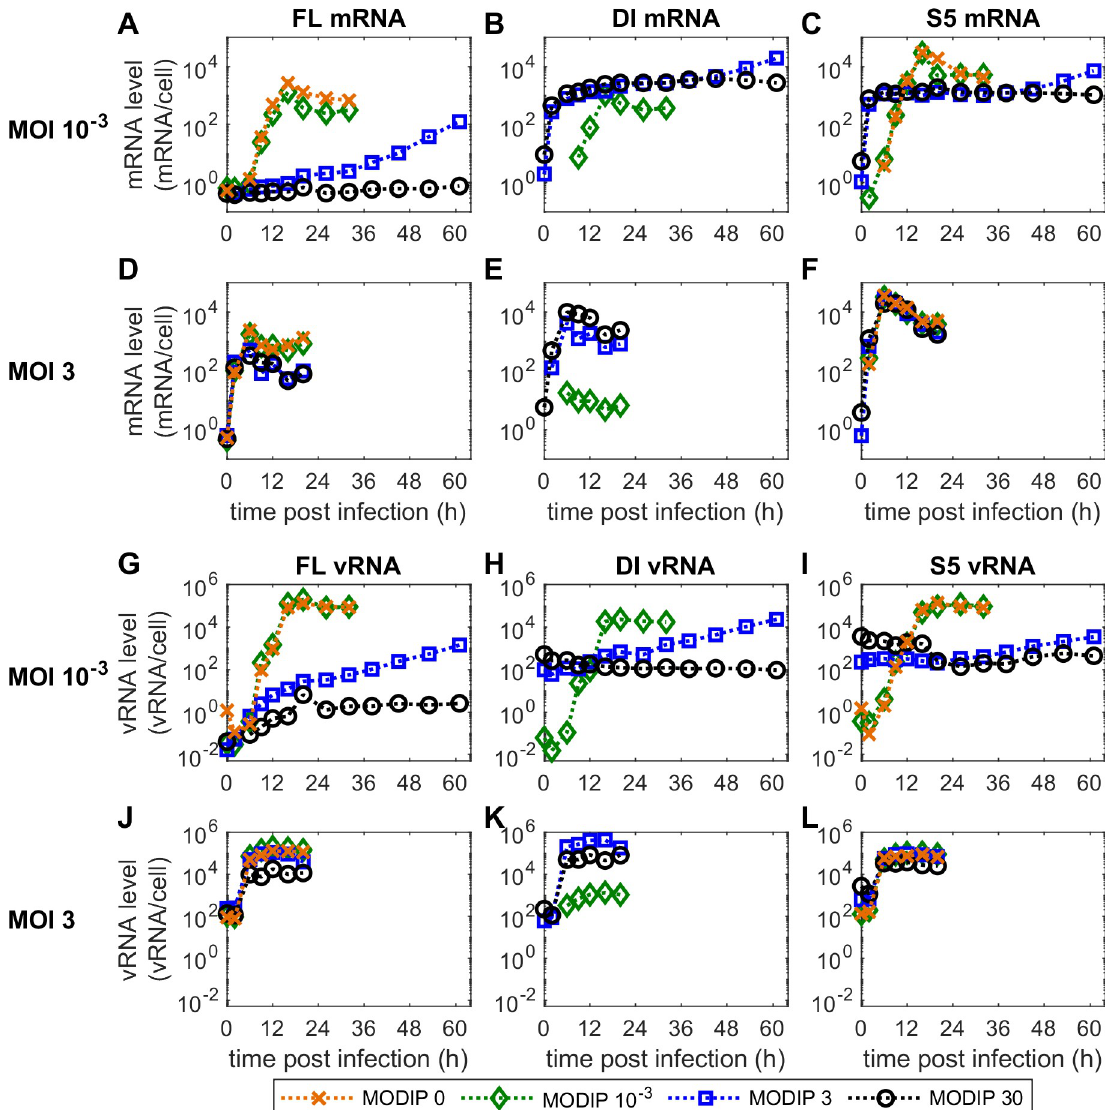
Fig 2. Viral RNA dynamics in infected MDCKsus cells are strongly influenced by the applied concentrations of STVs and DIPs. Real- time RT-qPCR measurements of (A-F) viral mRNA and (G-L) vRNA levels for different infection conditions. The results for (left) FL segment 1, (middle) DI segment 1 and (right) FL segment 5 are shown. Results for the remaining infection conditions are presented in S5– S7